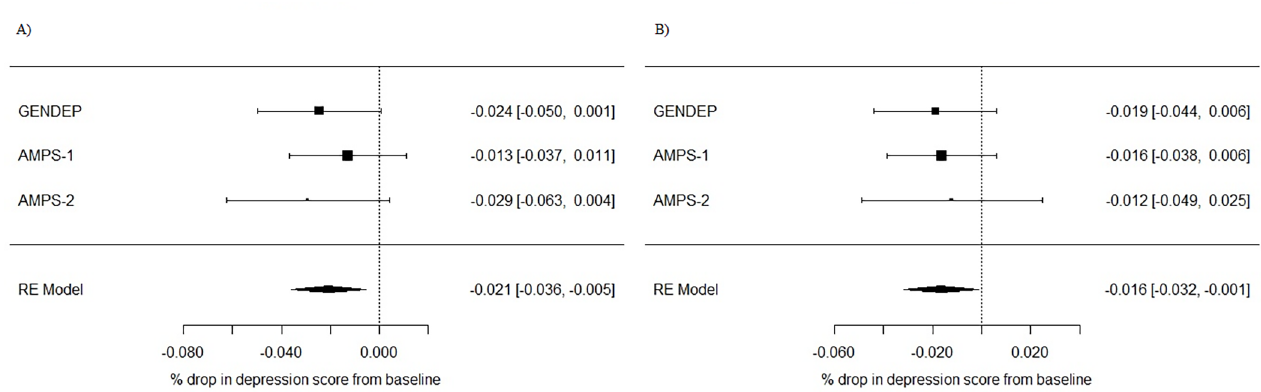
Fig 1. Forest plot of nominally significant meta-analyses. A) p < 5 (cid:3) 10 −5 MDD-PRS at 4 weeks, B) p < 0.1 Neuroticism-PRS at 8 weeks.